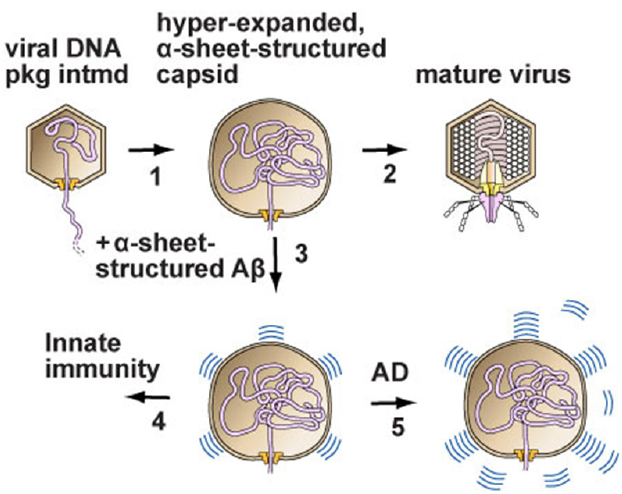
Figure 1. A skeletal model of phage T3 DNA packaging and a derivative model for the virus initiation of neurodegenerative diseases. (1) Packaging of phage T3 DNA involves hyper-expansion of the capsid’s outer shell when packaging via a packaging ATPase (not included in the drawing) slows. The hyper-expansion occurs via the taking by outer shell subunits of α -sheet conformation. α -sheet is a protein conformation that can be visualized in two dimensions by rotating every other amino acid in a β -sheet by 180°. (2) Packaging is completed, with the capsid contracting and, finally,